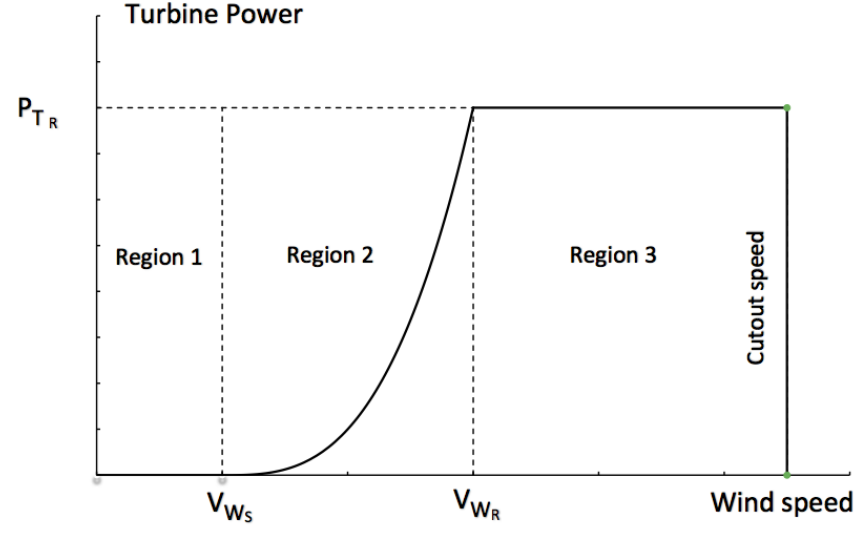
Figure 1. Typical turbine